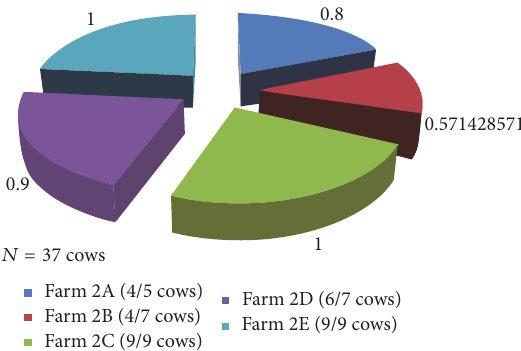
Figure 1: Proportion of cows that tested positive for mastitis on each farm in Keshunga subcounty.